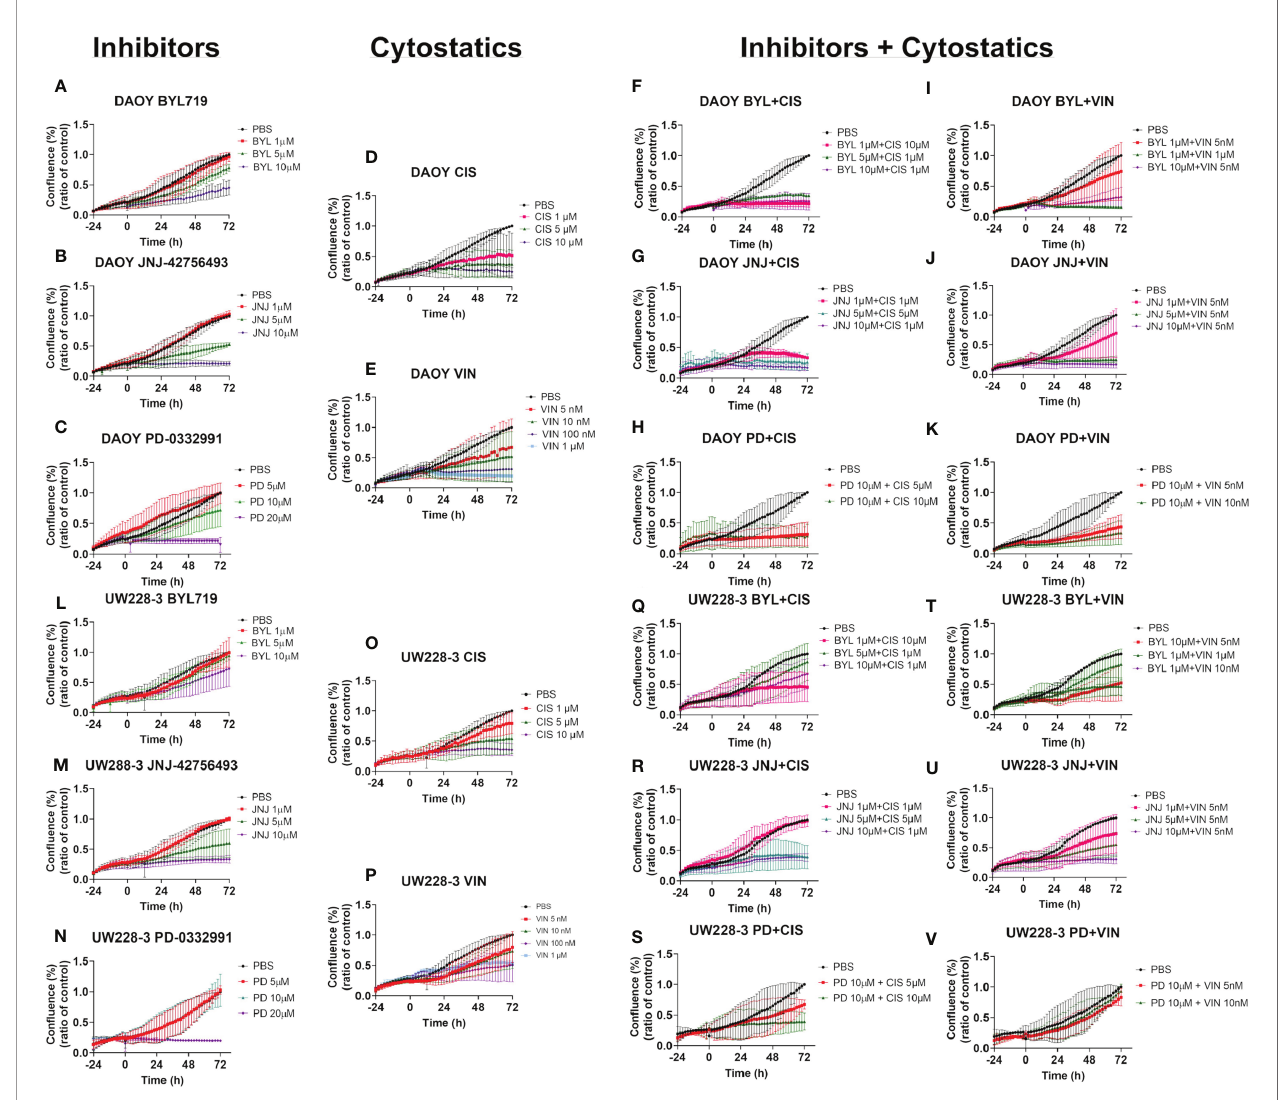
FIGURE 5 | Cell con fl uence after single and combination treatments with BYL719, JNJ-42756493, and PD-0332991 and cisplatin or vincristine on MB cell lines DAOY and UW228-3. Single treatments of DAOY and UW228-3, respectively, are shown for BYL719 in (A, L) ; JNJ-42756493 in (B, M) ; and for PD-332991 in (C, N) ; cisplatin in (D, O) and vincristine in (E, P) , respectively. Corresponding combination treatments of DAOY and UW228-3, respectively, with BYL719 and cytostatics are shown in (F, I, Q, T) ; with JNJ-42756493 and cytostatics in (G, J, R, U) ; and with PD-332991 and cytostatics in (H, K, S, V) , respectively. BYL, BYL719; JNJ, JNJ-42756493; PD, PD-0332991; CIS, cisplatin; VIN,